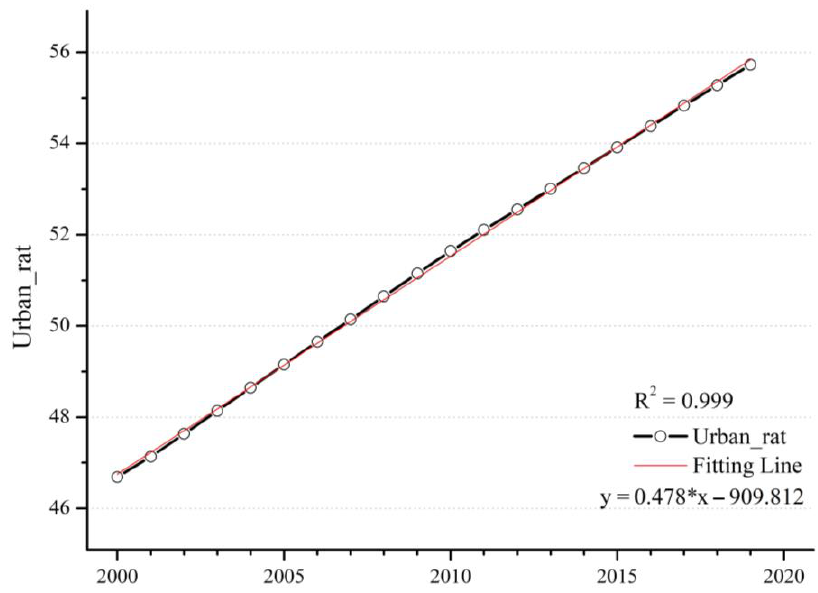
Figure 12. Time series of the global mean urban ratio from 2000 to 2019.